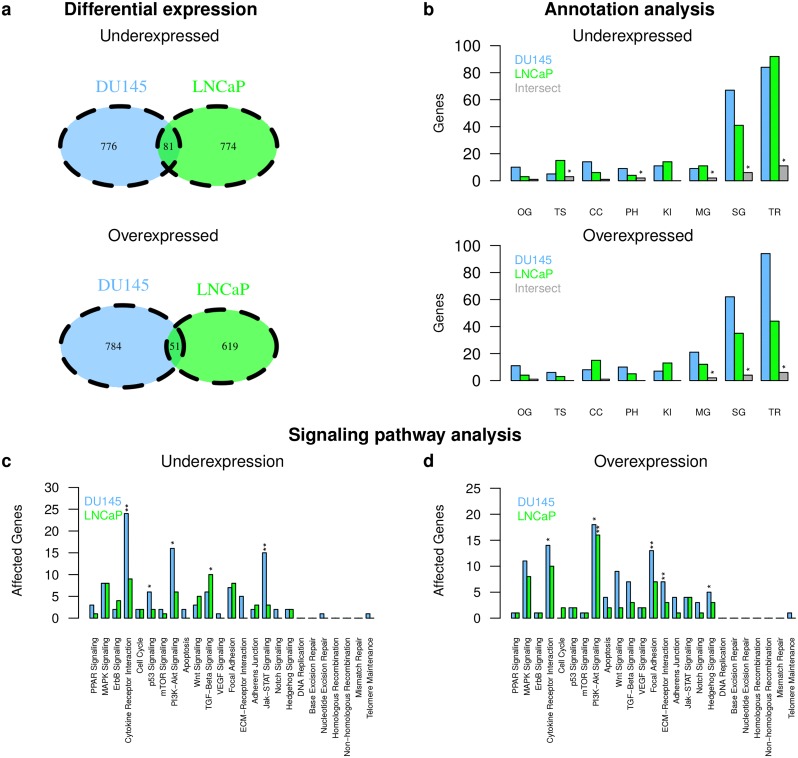
Gene expression differences between DU145 and LNCaP.Differentially expressed genes between radioresistant and radiosensitive cell lines were determined for DU145 and LNCaP. Identified under- (top panels) and overexpressed genes (bottom panels) in the radioresistant cell lines of DU145 and LNCaP were compared to each other at the single gene level (a) and at the level of cancer-relevant gene annotation categories (b; categories: oncogenes (OG), tumor suppressor genes (TS), cancer census genes (CC), phosphatases (PH), kinases (KI), metabolic pathway gene (MG), signaling pathway gene (SG), transcriptional regulator (TR)). Significant overlaps between categories are denoted by ‘*’ (b; grey columns, P < 0.001, Fisher’s exact test). Identified under- (c) and overexpressed genes (d) were further mapped to known cancer-relevant signaling pathways. Overrepresented pathways were highlighted by ‘*’ (P < 0.05, Fisher’s exact test) and ‘**’ (P < 0.01).